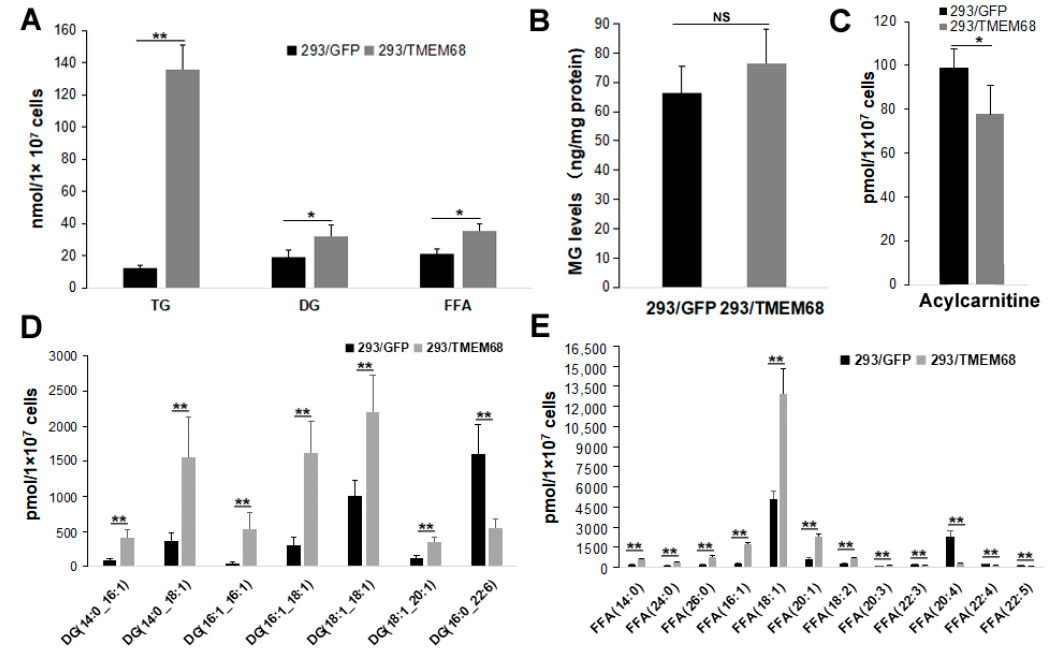
Figure 4. TMEM68 overexpression increases cellular TG, DG and FFA levels. TMEM68-overexpressing cells (293/TMEM68) and control cells (293/GFP) were collected for the quantification of various lipids by MetWare based on the AB Sciex QTRAP 6500 LC-MS/MS platform. ( A ) Levels of TG, DG and FFA in 293/GFP and 293/TMEM68 cells. ( B ) MG contents in 293/GFP and 293/TMEM68 cells as measured by ELISA. ( C ) Acylcarnitine level in 293/GFP and 293/TMEM68 cells. ( D , E ) Levels of DG ( D ), FFA ( E ) with differences ≥ 2.0 or ≤ 0.50 and VIP ≥ 1 between 293/GFP and 293/TMEM68 cells. Data are presented as means ± SD. NS, no significance. Asterisk indicated p values: * p < 0.05, ** p < 0.01, n = 6.